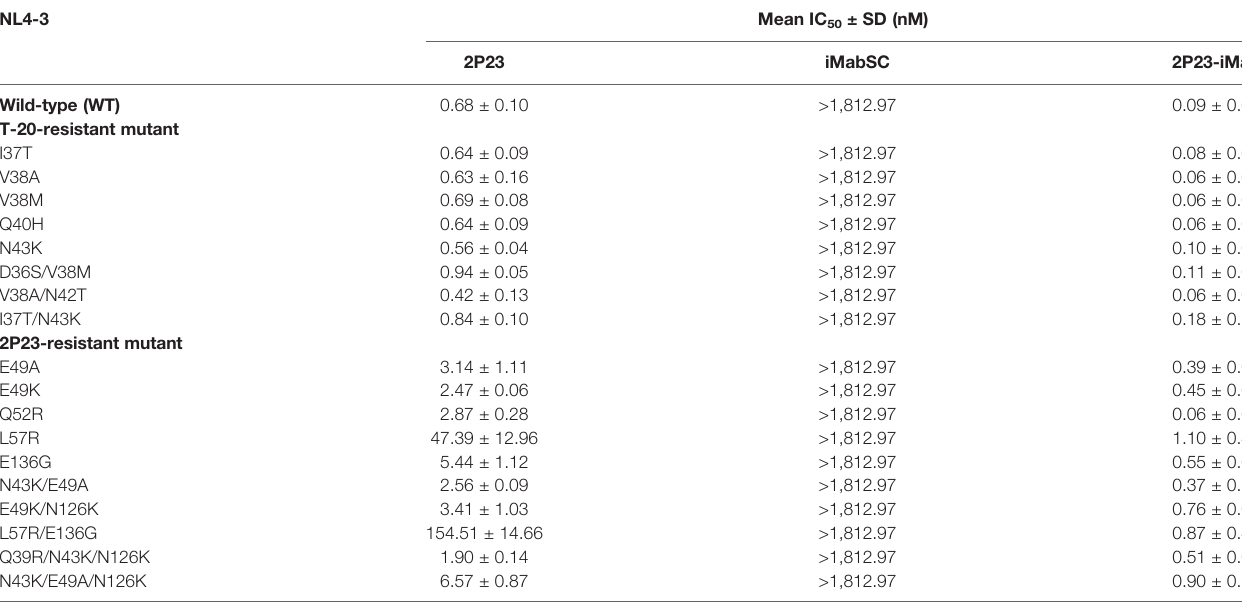
TABLE 4 | Inhibitory activities of 2P23-iMab and its template inhibitors against HIV-1 mutants resistant to T-20 or 2P23.